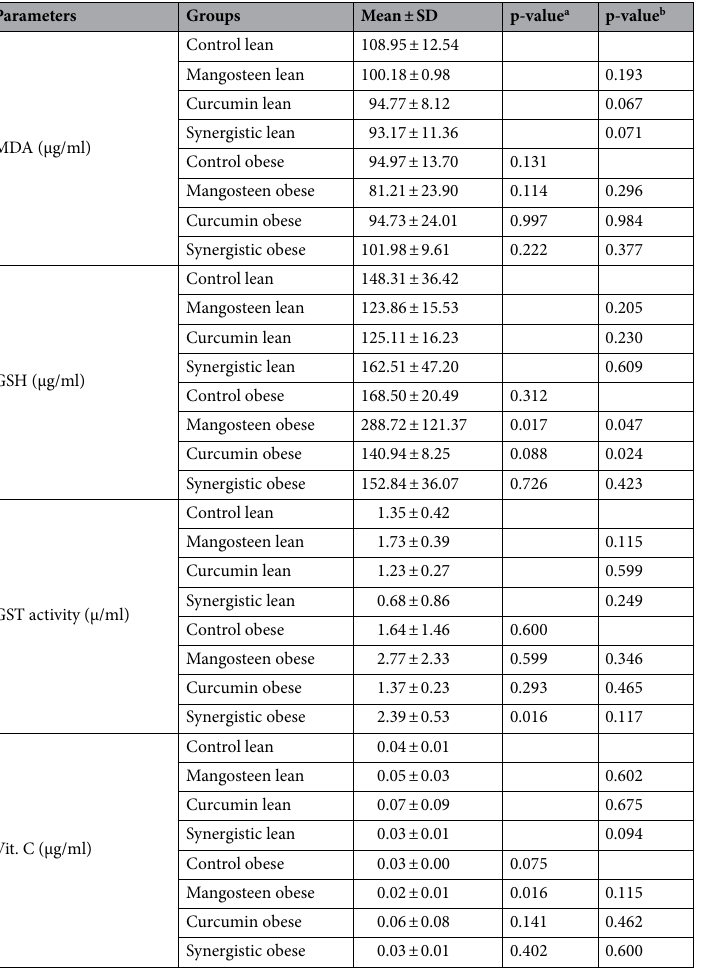
Table 2. Independent and synergistic effects of curcumin and mangosteen extract on oxidative stress- and antioxidant-related markers in lean and HFD-induced obese rats. a Significant difference between normal weight and obese rats in each group (control, mangosteen, curcumin, and synergistic). b Significant difference between each group and respective normal weight or obese control